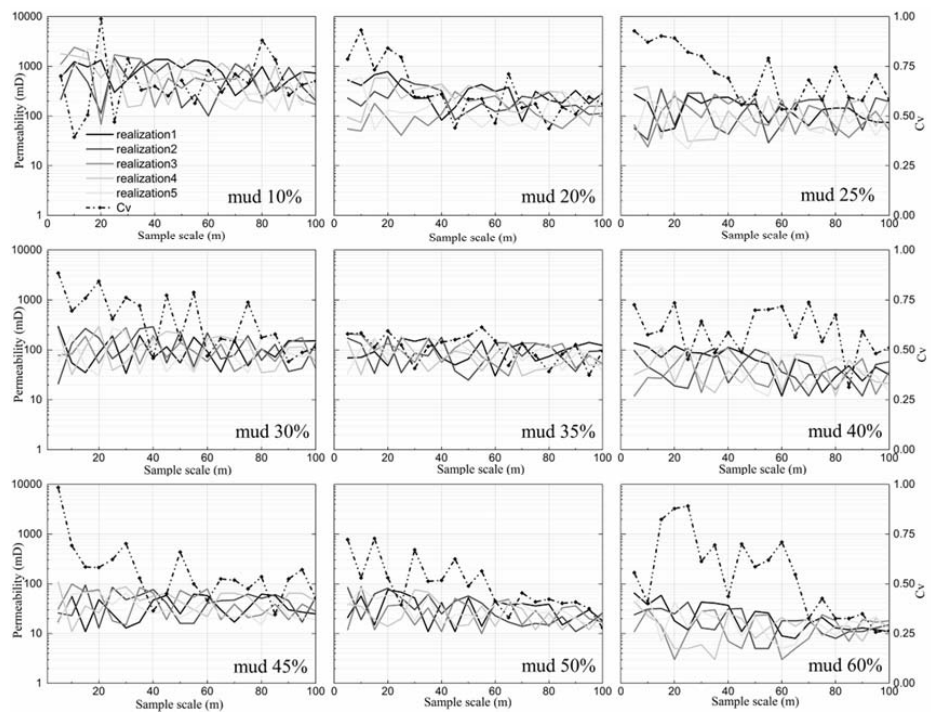
Figure 10. How the vertical permeability ( k v ) varies with the increase in sample size for ISWZs with varying width.